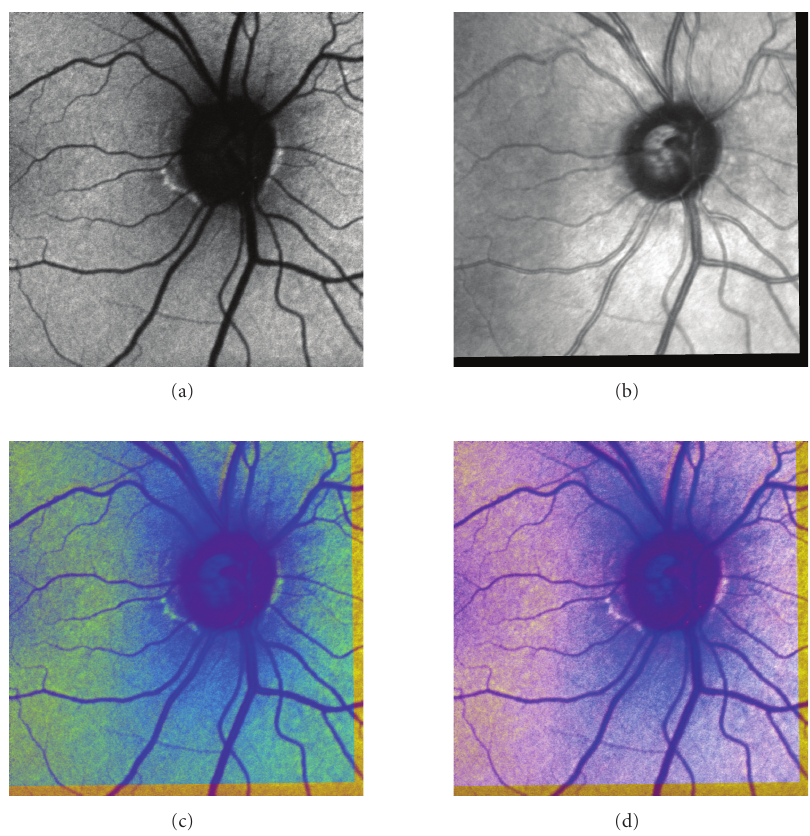
Figure 9: Example of AF-IR fusion results: (a) AF image, (b) IR image, (c) HVS method, (d) TV-IR